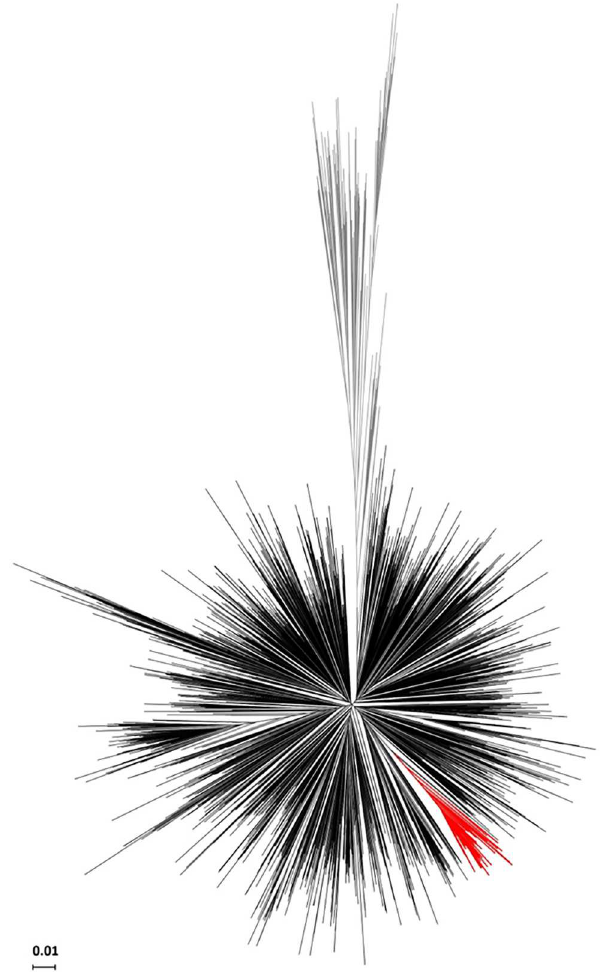
Fig 2. Phylogenetic tree of the HIV-1 subtype B dataset. The potentialtransmission cluster (n = 143) is highlightedin red, other subtype B sequencesare colored in black and the reference sequencesfrom other subtypes/CRFs are coloredin